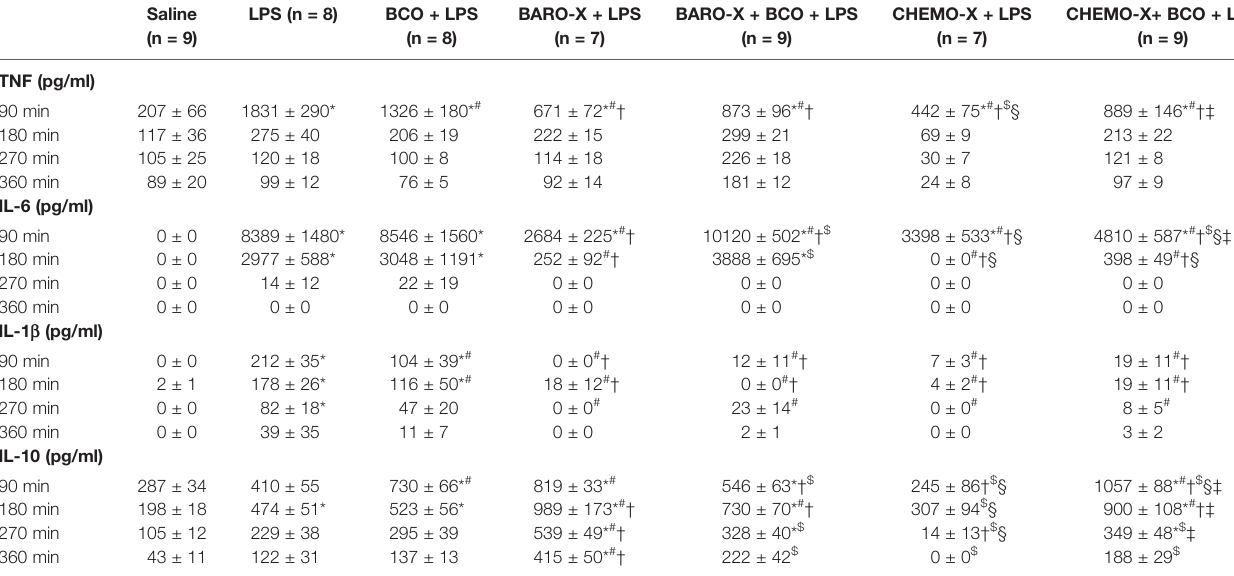
TABLE 1 | Time Course of Plasma